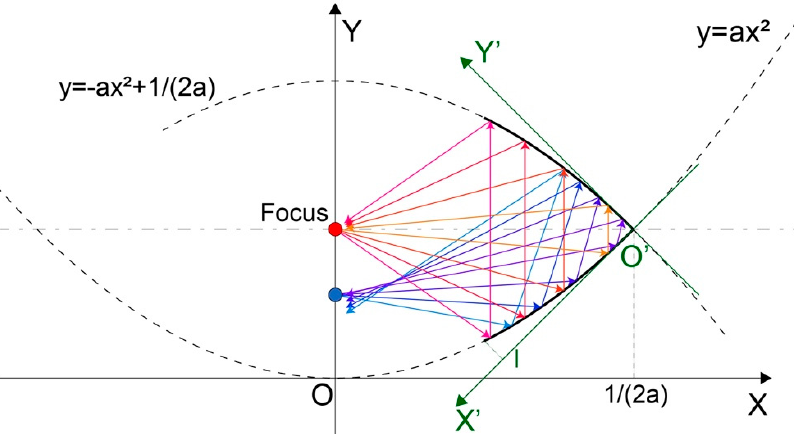
Figure A1. Geometry of co-focused parabolas, which together form a focusing dihedral retroreflector. For simplicity, y = ax 2 in XOY can be represented in X’O’Y’ using coordinate transfor- mation rules following Equation (A1).